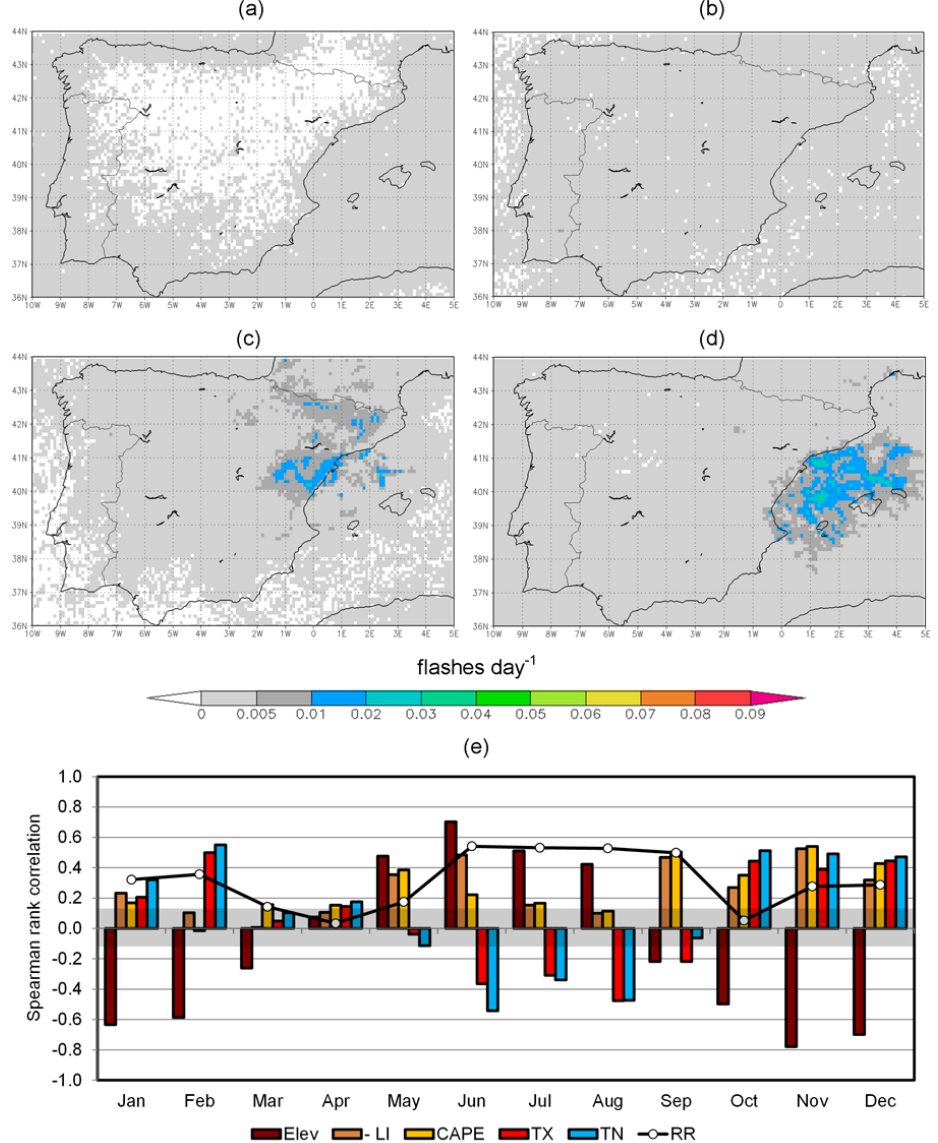
Fig. 5. As in Fig. 4, but only for the positive-polarity CGFs. The same colour scale as in Fig. 4 is also used here.